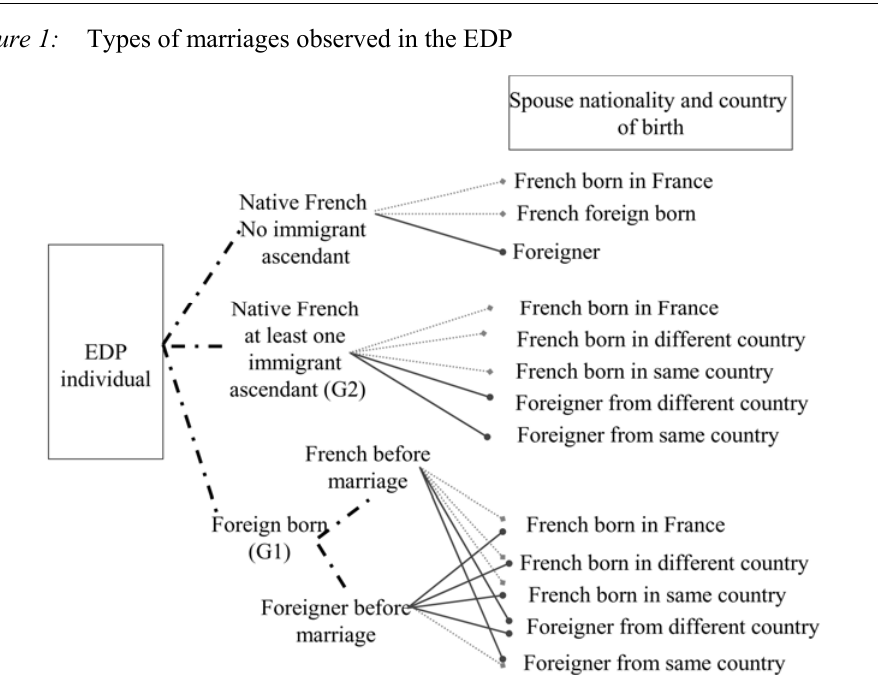
Figure 1: Types of marriages observed in the EDP